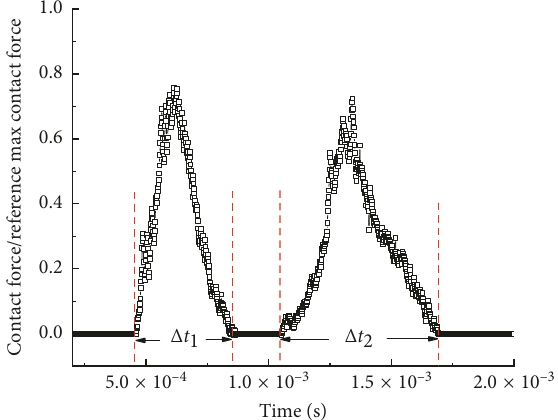
Figure 22: Time history of the contact force on the casing with lower yield strength.